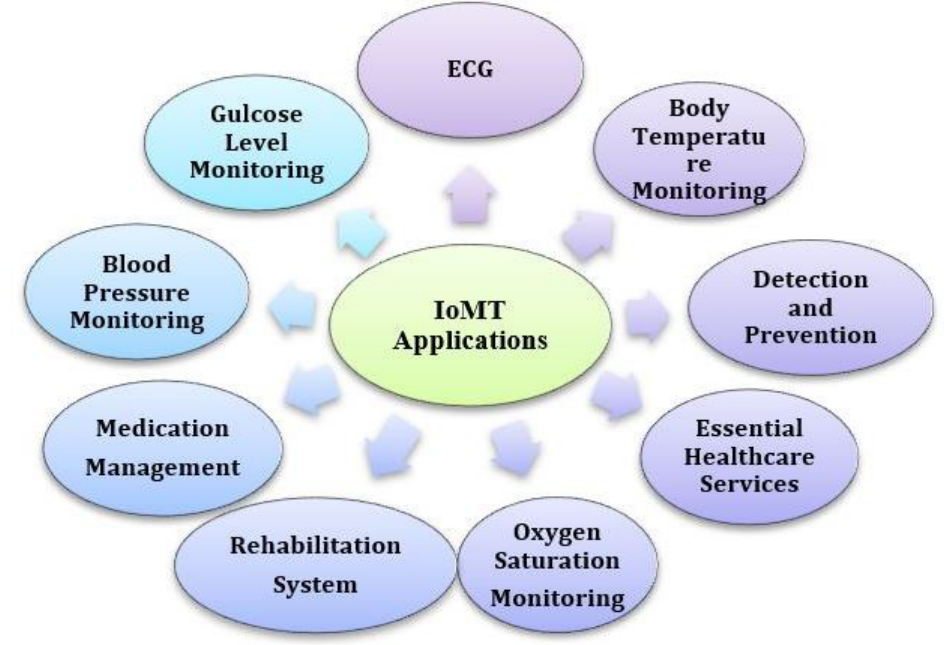
Figure 1. Applications of Internet of Medical Things